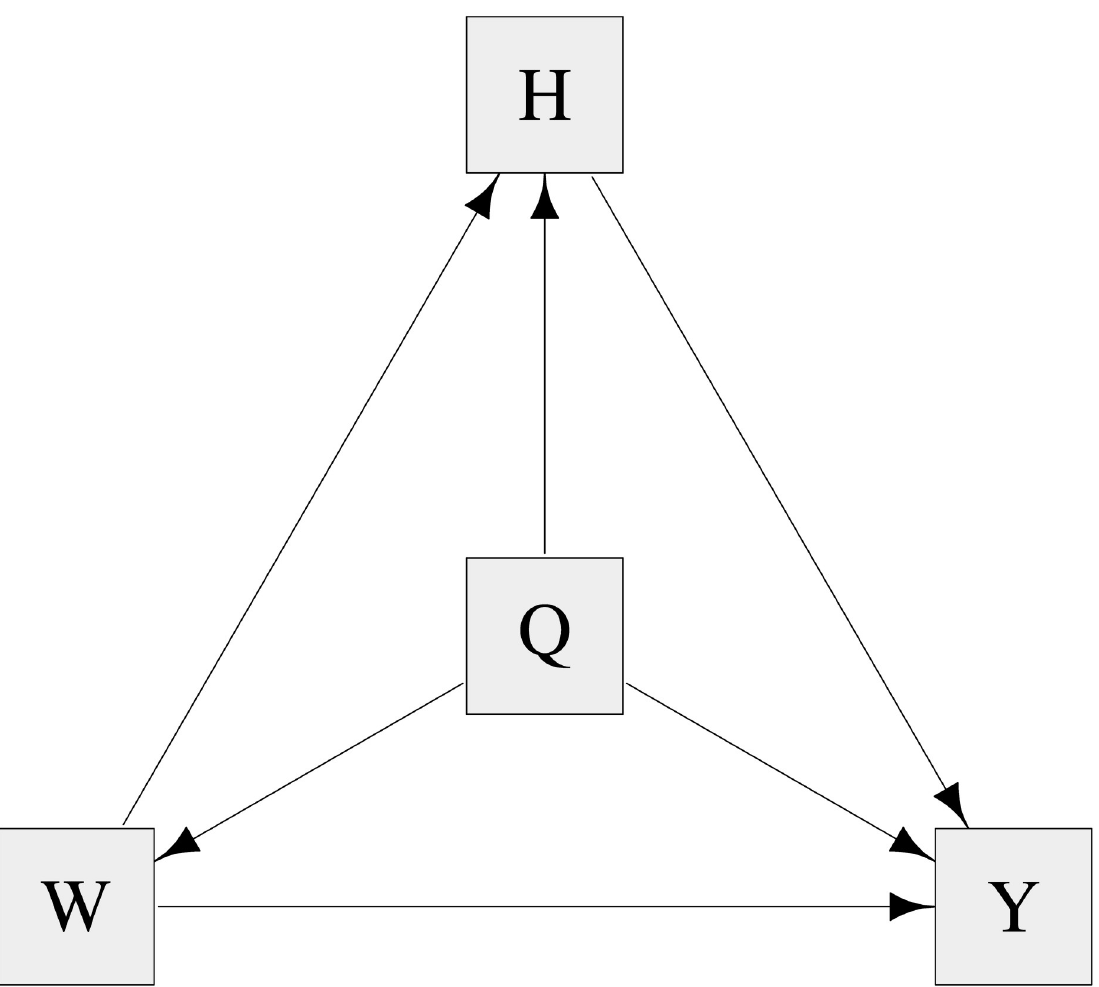
Fig 7. Graph of the simulation model used for simulation study 2 for four different parameter scenarios as described by Shih et al. [55]. The data simulated consisted of four binary variables: Q, representing a gene; W, representing high alcohol; H, representing high alanine transaminase; and the outcome variable, Y, representing hepatocellular carcinoma.